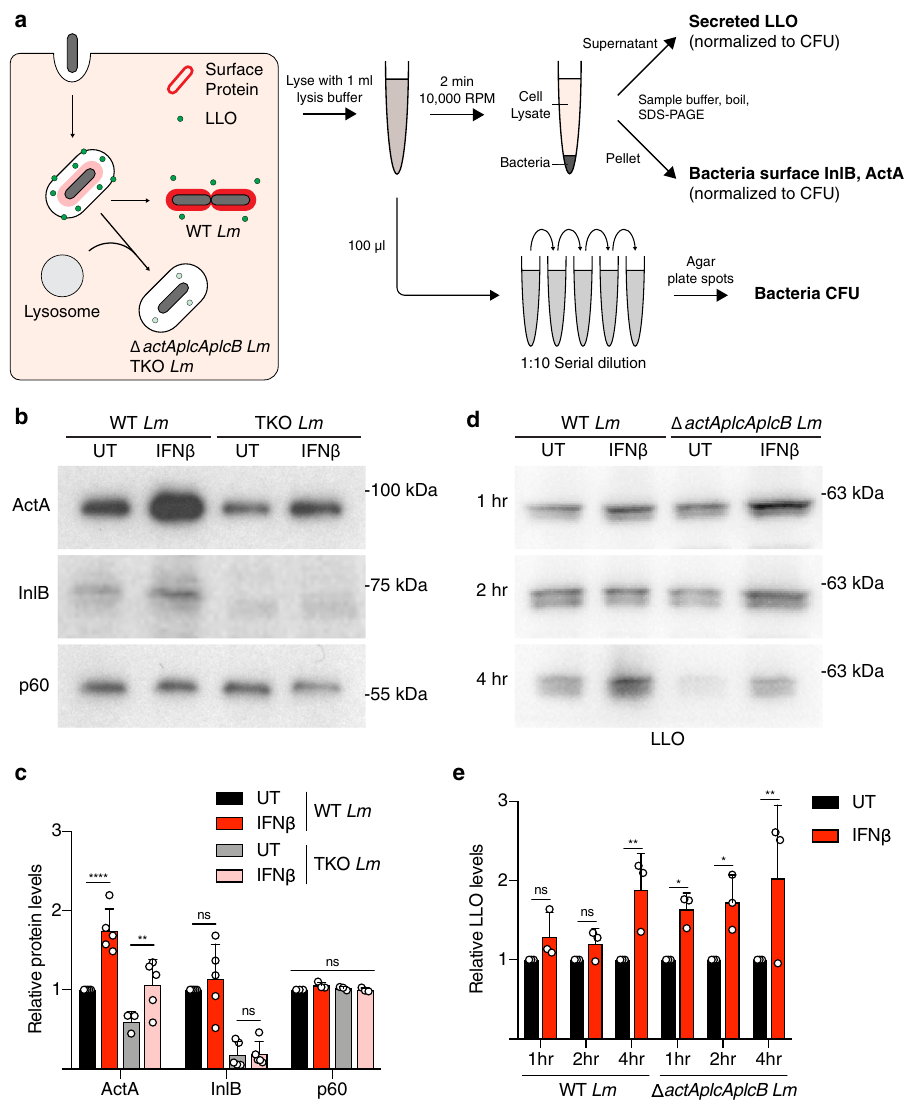
Fig. 4 Type I IFN suppresses Lm virulence factor degradation in phagosomes. a Schematic of experimental protocol detailing methods to obtain secreted and bacterial lysate fractions from BMDMs infected with indicated Lm strains. Representative images ( b ) and quanti fi cation ( c ) of ActA and InlB on the bacteria surface measured by western blot in BMDMs infected with indicated Lm strains 4 h p.i. Cell wall-associated protein p60 used as loading control. ** P = 0.002, **** P < 0.0001. Representative images ( d ) and quanti fi cation ( e ) of LLO measured by western blot in BMDMs infected with indicated Lm strains over 4 h. * P < 0.0295, ** P < 0.0039. Data shown are means ± standard deviation (s.d.) for at least n = 3 independent experiments. P value was calculated using two-way ANOVA. ns not signi fi cant, P > 0.1301. Source data are provided as a Source Data fi